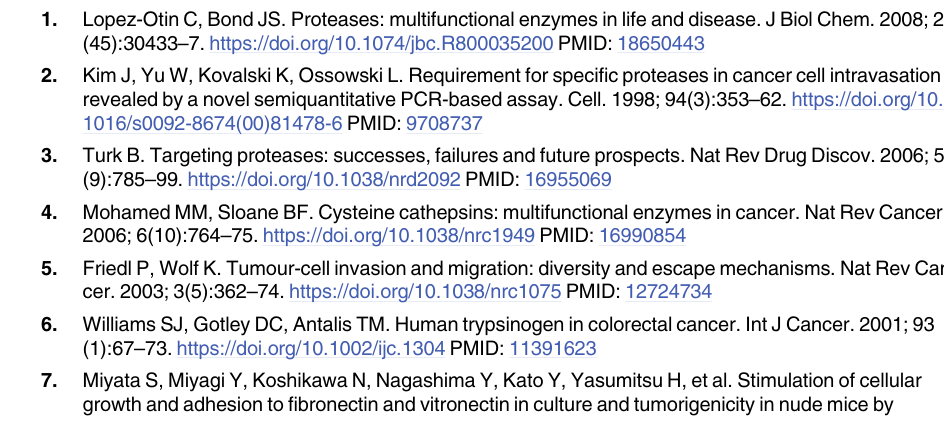
S2 Fig. Tissue distribution of PAR2 activating factors between OSE and ovarian cancer tis- sues was analyzed from the Mixed Ovarian-Birrer-63-MAS5.0-u133p2 dataset; (OSE: Ovarian Surface Epithelium, N = 10; ovarian tumor: papillary serous ovarian adenocarci- noma, N = 53); ns: not significant; ���� : p < 0.0001 (unpaired t test); TF: tissue factor. S3 Fig. Trypsin activity was measured by the proteolytic cleavage of its substrate ( N zoyl-DL-arginine p -nitroanilide). The release of p -nitroanilide was colorimetrically detected at λ = 415 nm. Tr: trypsin (150 nM); HE4 (100 nM; Novoprotein Cat. #: